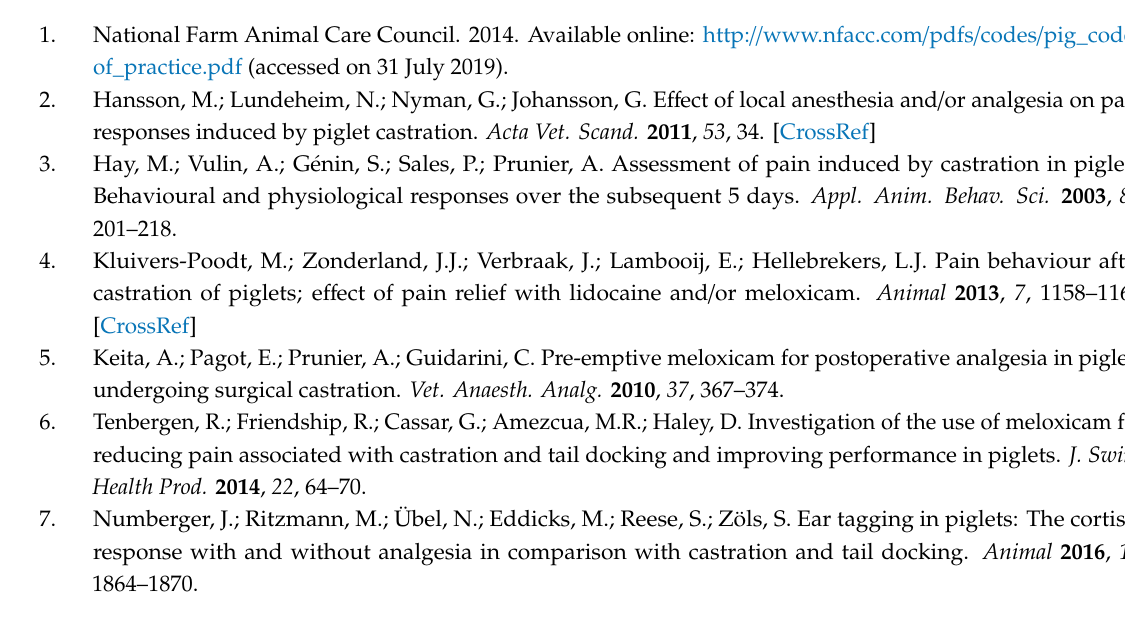
Table S1: Final full model (model 1) of overall navigation time (seconds) by treatment group using meloxicam and iron dextran (M + ID) treatment group as the referent category, Table S2: Final full model (model 1) of overall navigation time (seconds) by treatment group using ketoprofen and iron dextran (K + ID) treatment group as the referent category, Table S3: Final full model (model 1) of overall navigation time (seconds) by treatment group using castration without analgesia and iron dextran (C + ID) treatment group as the referent category, Table S4: Final full model (model 3) of cortisol (nmol / L) 1-h post-castration by treatment group using meloxicam and iron dextran (M + ID) treatment group as the referent category, Table S5: Final full model (model 3) of cortisol (nmol / L) 1-h post-castration by treatment group using ketoprofen and iron dextran (K + ID) treatment group as the referent category, Table S6: Final full model (model 3) of cortisol (nmol / L) 1-h post-castration by treatment group using castration without analgesia and iron dextran (C + ID) treatment group as the referent category, Figure S1. Comparison of navigation time (sec) at 15 min post-castration between treatment groups using simple linear regression, controlling for fixed e ff ects of navigation timepoint, baseline navigation time, back test score and batch, Figure S2. Comparison of navigation time (sec) at 30 min post-castration between treatment groups using simple linear regression, controlling for fixed e ff ects of navigation timepoint, baseline navigation time, back test score and batch, Figure S3. Comparison of navigation time (sec) at 1 h post-castration between treatment groups using simple linear regression, controlling for fixed e ff ects of navigation timepoint, baseline navigation time, back test score and batch, Figure S4. Comparison of navigation time (sec) at 4 h post-castration between treatment groups using simple linear regression, controlling for fixed e ff ects of navigation timepoint, baseline navigation time, back test score and batch, Figure S5. Comparison of navigation time (sec) at 24 h post-castration between treatment groups using simple linear regression, controlling for fixed e ff ects of navigation timepoint, baseline navigation time, back test score and batch, Figure S6. Comparison of navigation time (sec) at 30 h post-castration between treatment groups using simple linear regression, controlling for fixed e ff ects of navigation timepoint, baseline navigation time, back test score and